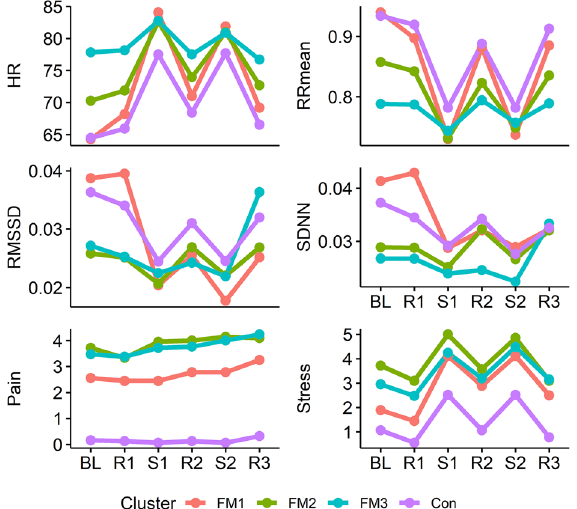
Figure 3. Mean heart rate (HR, beats per minute), RMSSD (ms), subjective pain (numeric rating scale [NRS] from 0 to 10), and subjective stress (NRS from 0 to 10) levels during the measurement in the three fibromyalgia patient clusters (FM1, 2, 3) and healthy controls (Con). BL baseline, R1 first relaxation phase, S1 first cognitive stress phase, R2 second relaxation phase, S2 second cognitive stress phase, R3 third and final relaxation